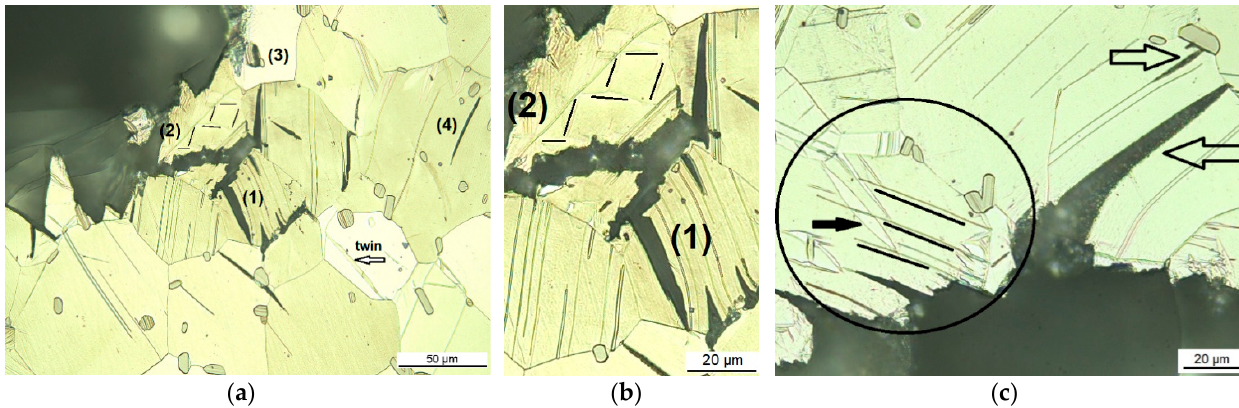
Figure 6. Cross-sectional optical micrographs of the crack path in the Mg-Dy-Nd-Zn-Zr alloy C-ring samples for the Figure 6. Cross ‐ sectional optical micrographs of the crack path in the Mg ‐ Dy ‐ Nd ‐ Zn ‐ Zr alloy C ‐ ring samples for the coarse-grained microstructure: solution heat-treated at 500 ◦ C for 72 h ( a , c ), ( b ) magnified area from micrograph ( a coarse ‐ grained microstructure: solution heat ‐ treated at 500 °C for 72 h ( a , c ), ( b ) magnified area from micrograph ( a ).